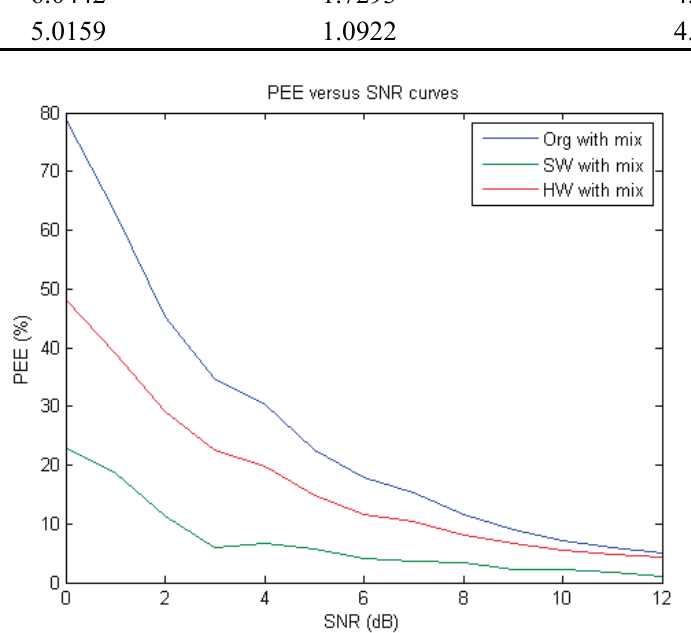
Figure 17. The PEE- versus -SNR curves derived from the original 60 Hz power interference and Gaussian noise-corrupted ECGs (blue), the software-based de-noised ECGs (green), and the hardware-based de-noised ECGs (red),